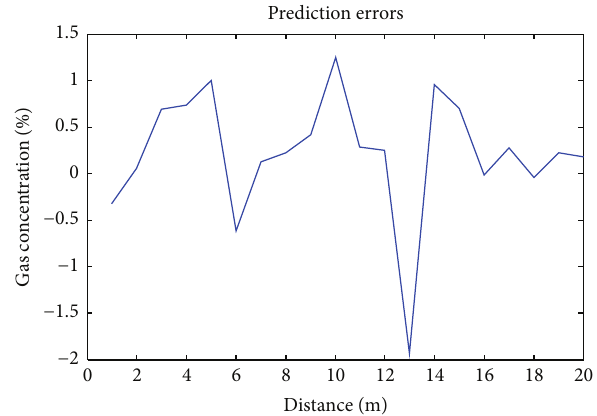
Figure 9: The prediction errors of the gray neural network.